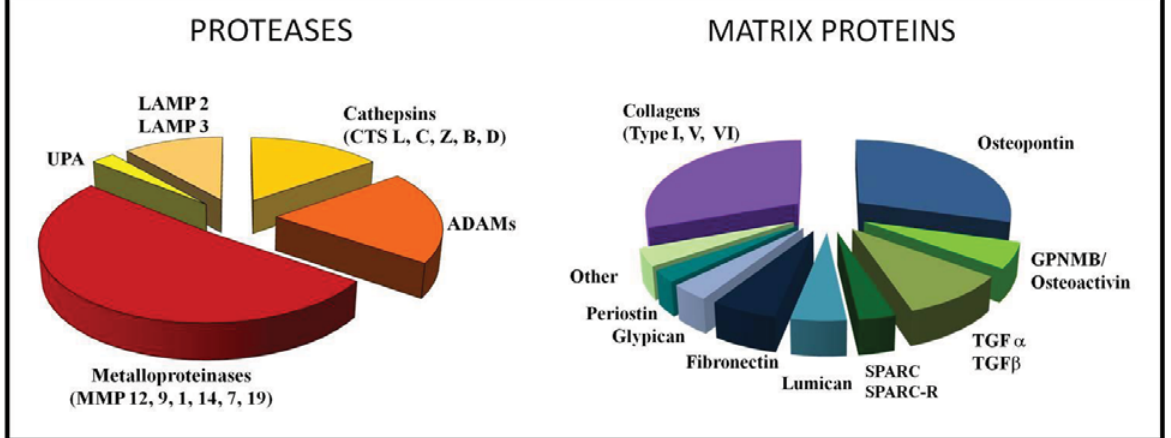
Figure 2. Gene expression profile of human tumor-associated macrophages. The data refer to the expression of genes coding for proteolytic enzymes or ECM proteins. Results are mean values from 7 different TAM preparations. Each depicted slice is proportional to the expression level of each gene